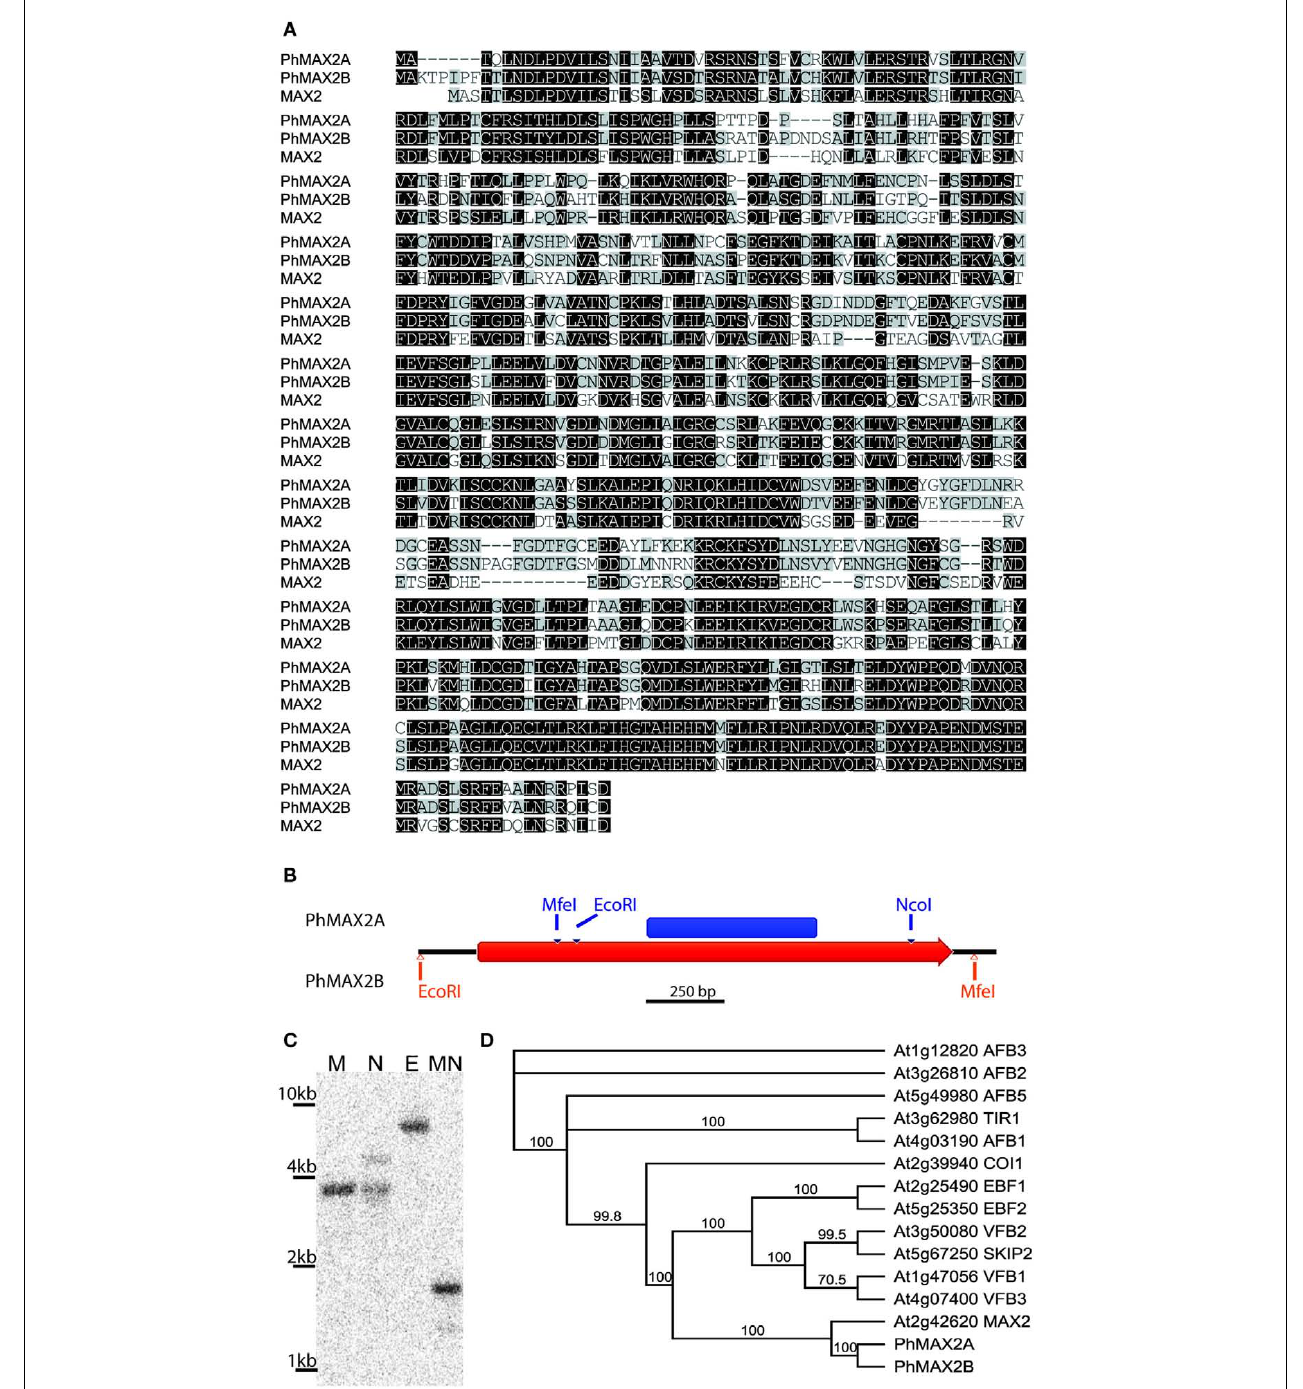
above the sequence as a blue bar. (C) A petunia genomic DNA Southern blot probed with a fragment of PhMAX2A .The lanes are: M, Mfe I; N, Nco I digest; E, Eco RI digest; MN, Mfe I Nco I double digest. (D) A maximum likelihood phylogeny showing the PhMAX2A and PhMAX2B proteins in relation to the LRR7 F-Box proteins in Arabidopsis . Sequences have been given theirTAIR locus number and any gene name associated with the sequence.The tree is unrooted and the values indicated on branches are bootstrap percentages over 1000